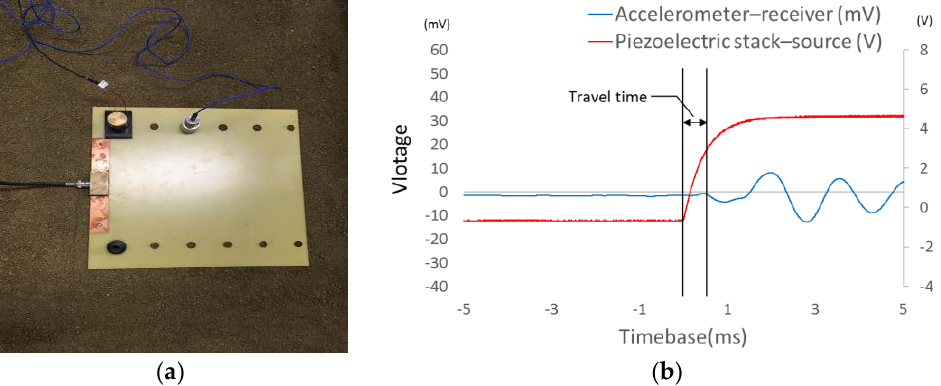
Figure 8. Shear wave velocity measurement and result: ( a ) Shear wave velocity measurement; ( b ) Travel time of elastic wave obtained by using the Piezoelectric stack.